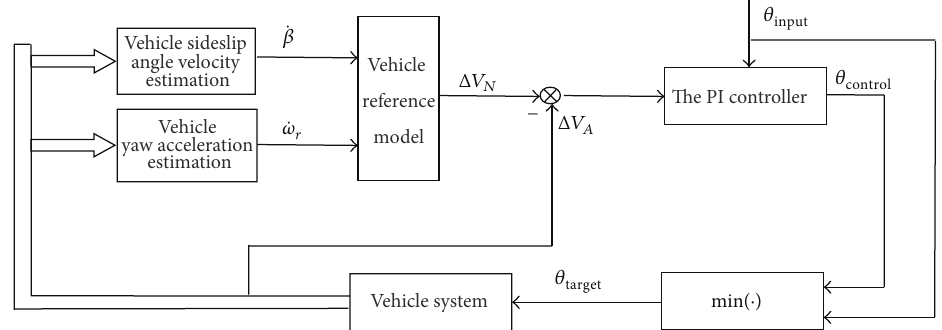
Figure 3: Principle of vehicle dynamic stability control chart.